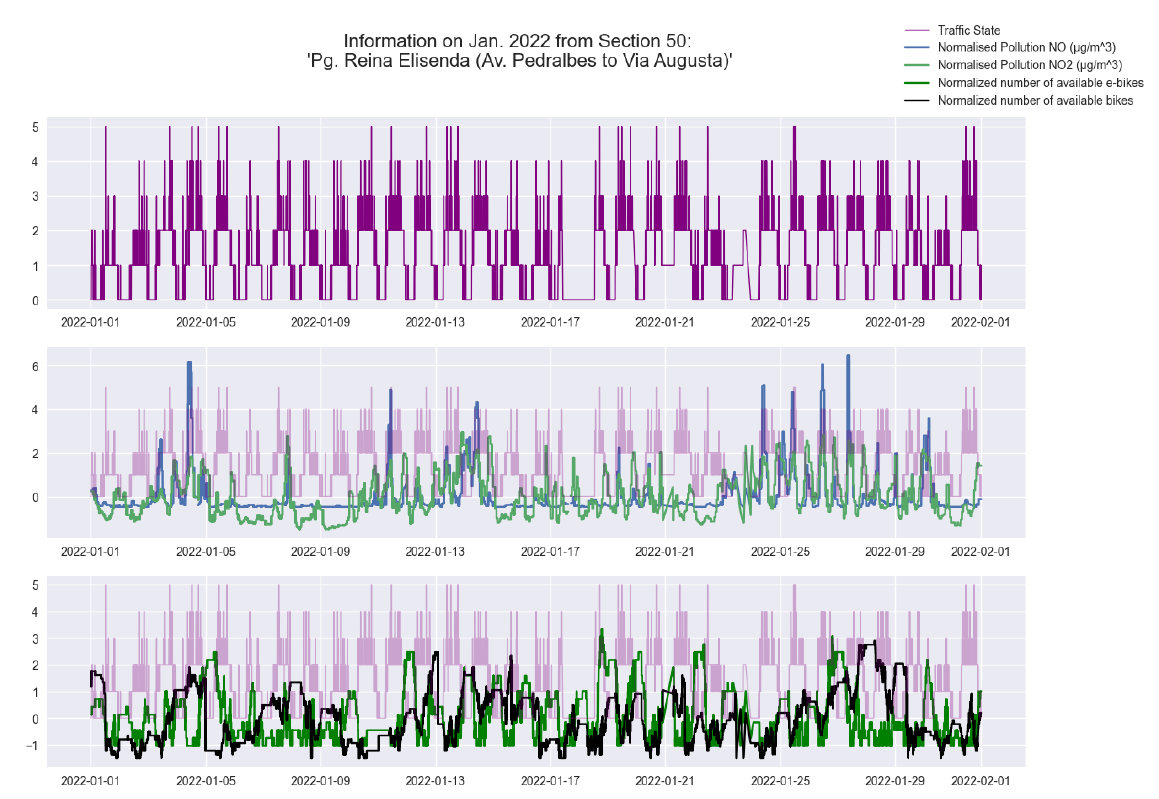
Figure 5. Comparison of three time series: original traffic density ( top ), generated normalized NO/NO 2 pollution ( middle ), and generated normalized public bike availability in Barcelona ( bottom